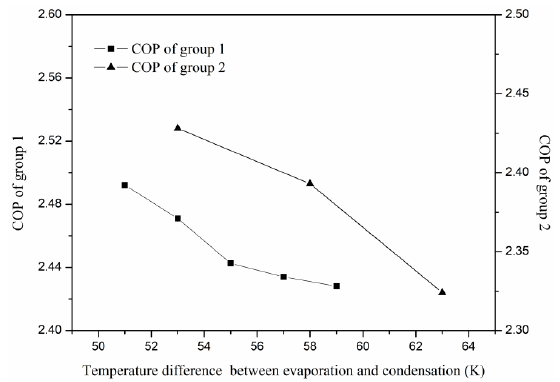
Figure 3. Effect of temperature difference between evaporation and condensation on COP.